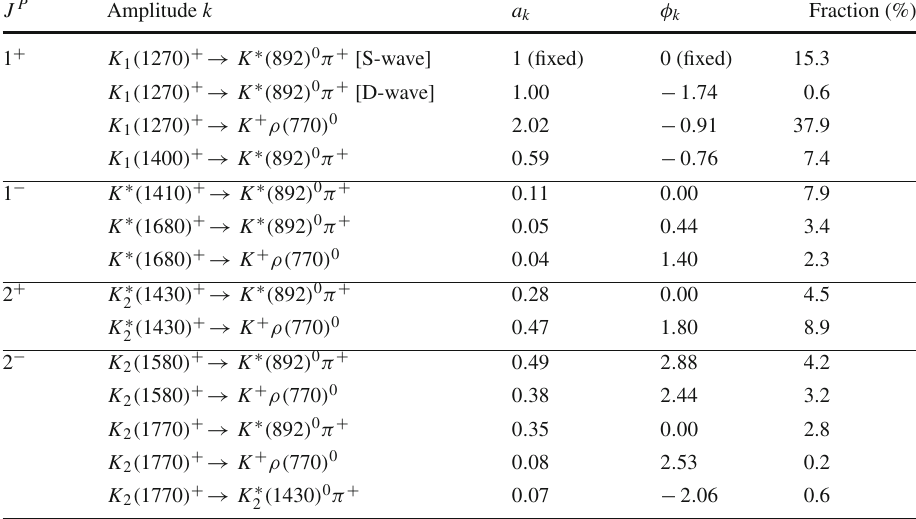
Table 2 Model used to describe the K + res → K + π − π + hadronic system in the B + → K + π − π + γ decays. The table is divided in sections according to the spin-parity J P of the K res resonance. The amplitude with the S-wave decay K 1 ( 1270 ) + → K ∗ ( 892 ) 0 π + is chosen as a reference for the magnitudes and